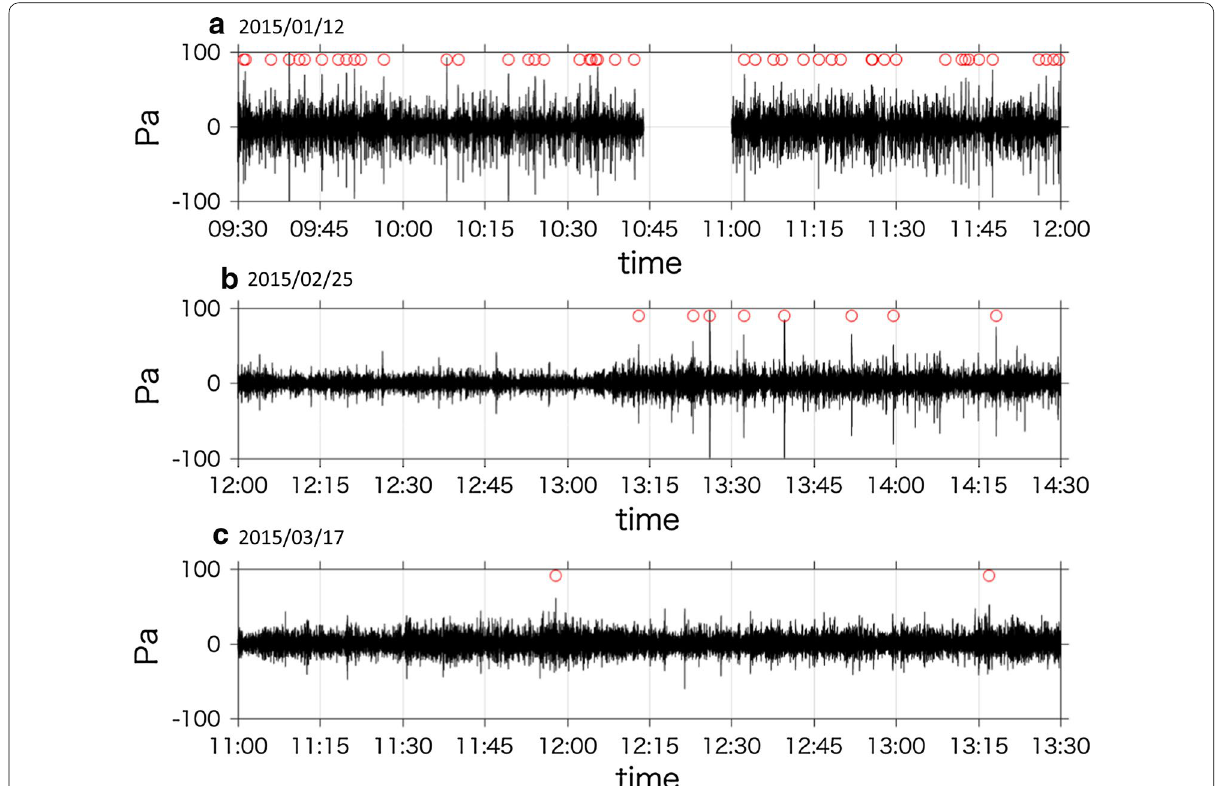
Fig. 7 Infrasonic waveforms observed at the location 4 on Fig. 1. Red circles indicate explosions with peak pressures of > 50 Pa. Data-gap of 15 min was due to works at the